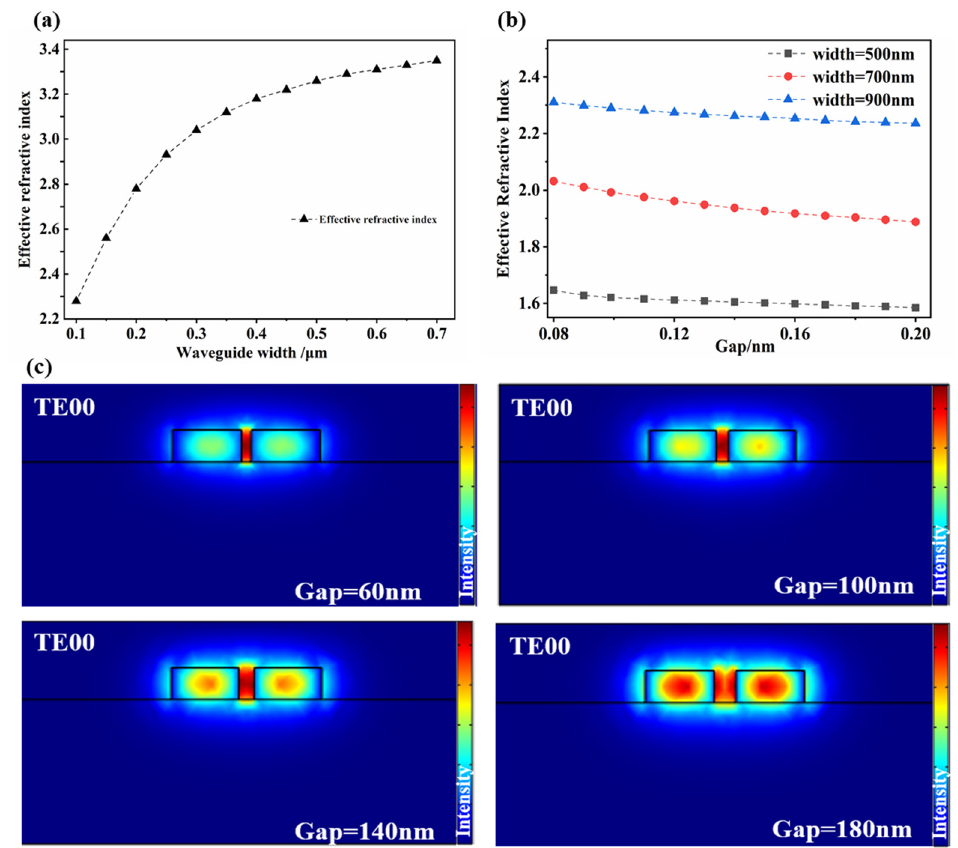
Figure 2. ( a ) The relationship between different waveguide widths and the effective refractive index, ( b ) the relationship between different waveguide widths/gaps and the effective refractive index, and ( c ) the electric field pattern distribution diagram with a width of 450 nm and different gaps.